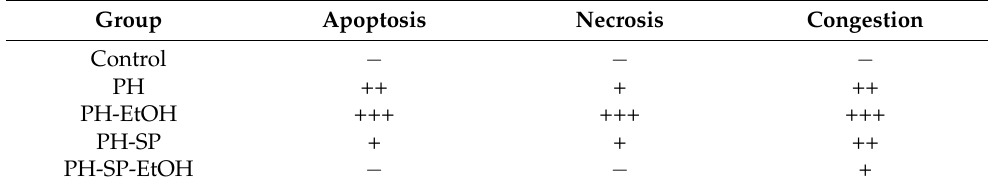
Table 2. Histological indicators. Liver lesion parameters in each experimental group treated (n = 6).